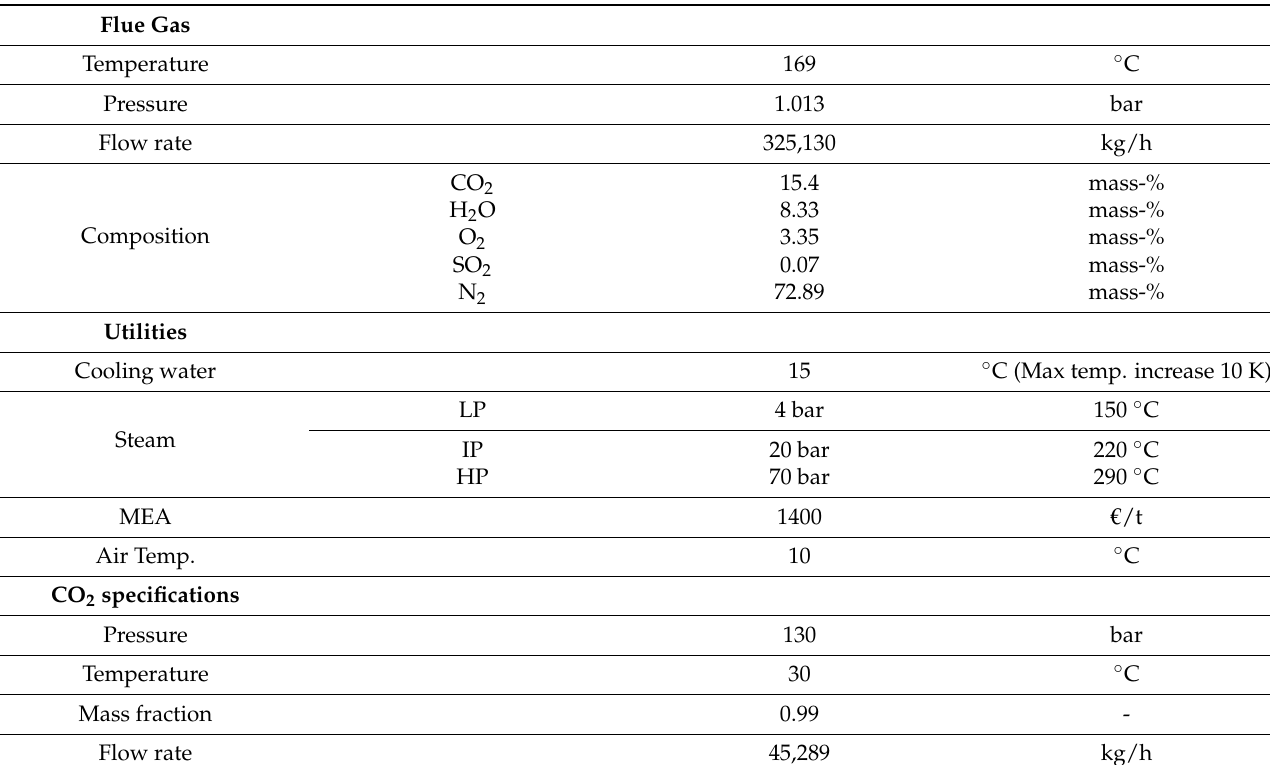
Figure 2. Process schematic of CO 2 capture using MEA solvent (left to right: desulfurization, flue gas cooling, absorp- tion/desorption, CO 2 compression train). Table 1. Flue gas and utility